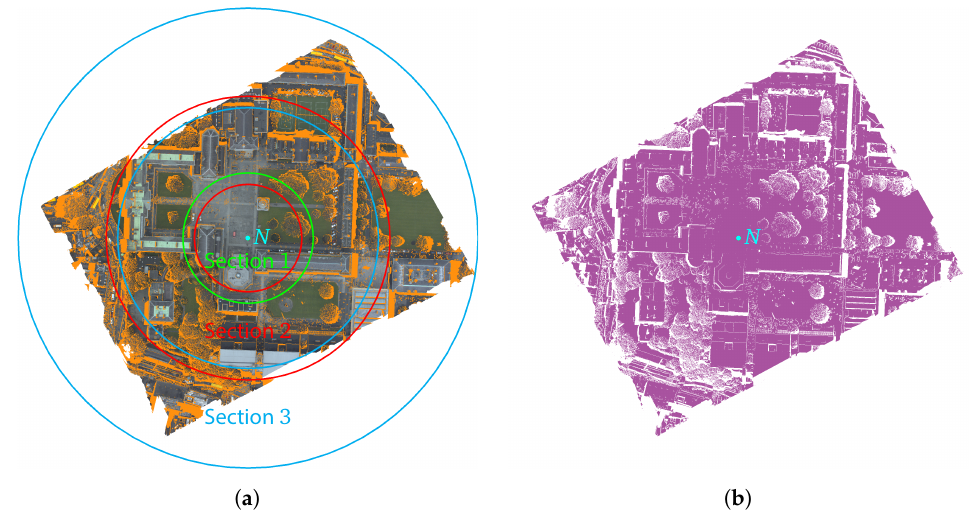
Figure 11. Occlusion detection result for an image: ( a ) Detected occlusions (orange areas) visualized on an orthophoto; and ( b ) Respective visibility map representing the visible DSM cells (magenta portions). Having generated visibility maps for the overlapping images, it is feasible to identify the DSM cells which are visible/occluded in each image. If a DSM cell is occluded in an image, adjacent images from which that DSM cell is visible are identified by checking the respective visibility maps. As a basic mosaicking approach, spectral information can be assigned to the orthophoto pixel corresponding to the occluded cell from the closest visible image. As such, horizontal distances between the DSM cell and perspective centers of visible images are computed to find the closest image. The DSM cell is then projected to that image using the respective IOPs and EOPs by means of collinearity equations. The spectral information of the corresponding image pixel is then assigned to the respective orthophoto pixel. The closest visible image identification and projection processes are repeated for the entire DSM cells until appropriate spectral information is derived for all orthophoto pixels. This mosaicking approach ensures the occluded areas are filled by correct spectral information, thereby avoiding the double-mapping problem. However, spectral dissimilarity may appear in the true orthophoto since the images might be taken in different lighting conditions. Such spectral discontinuities (known as seamlines) take place at the borders of image portions in the true orthophoto. Figure 12a shows the contribution of images to part of a true orthophoto generated using the closest visible image criteria. In this figure, each color represents an area for which spectral information has been derived from an individual image. The random colors clarify that in an area covered by a closest image (e.g., the light green portion), spectral information for occluded portions are derived from neighboring closest images. Filling such occluded portions from the adjacent images (i.e., especially images form the neighboring flight lines) may also lead to spectral dissimilarity. Some studies have been carried out to adjust the spectral information along seamlines appearing in true orthophotos. As an example, De Oliveira et al. [35] considered a buffer area around each seamline and blended the spectral information of the involved images using a weighted averaging method. Although this approach mitigates the seamline effect, the color transition takes place within a narrow buffer area along each seamline. Moreover, this method does not address the spectral variations at the border of occluded areas. As such, a weighted averaging method is proposed to balance the spectral information over the entire area of the true orthophoto. In this approach, spectral information for each orthophoto pixel is sampled from all the visible images using the inverse distance weighting (IDW) method proposed by Shepard [39]. If n is a set of images from which a DSM cell is visible, spectral information for the corresponding orthophoto pixel (e.g., s ( p ) ) is computed from the spectral information of those images